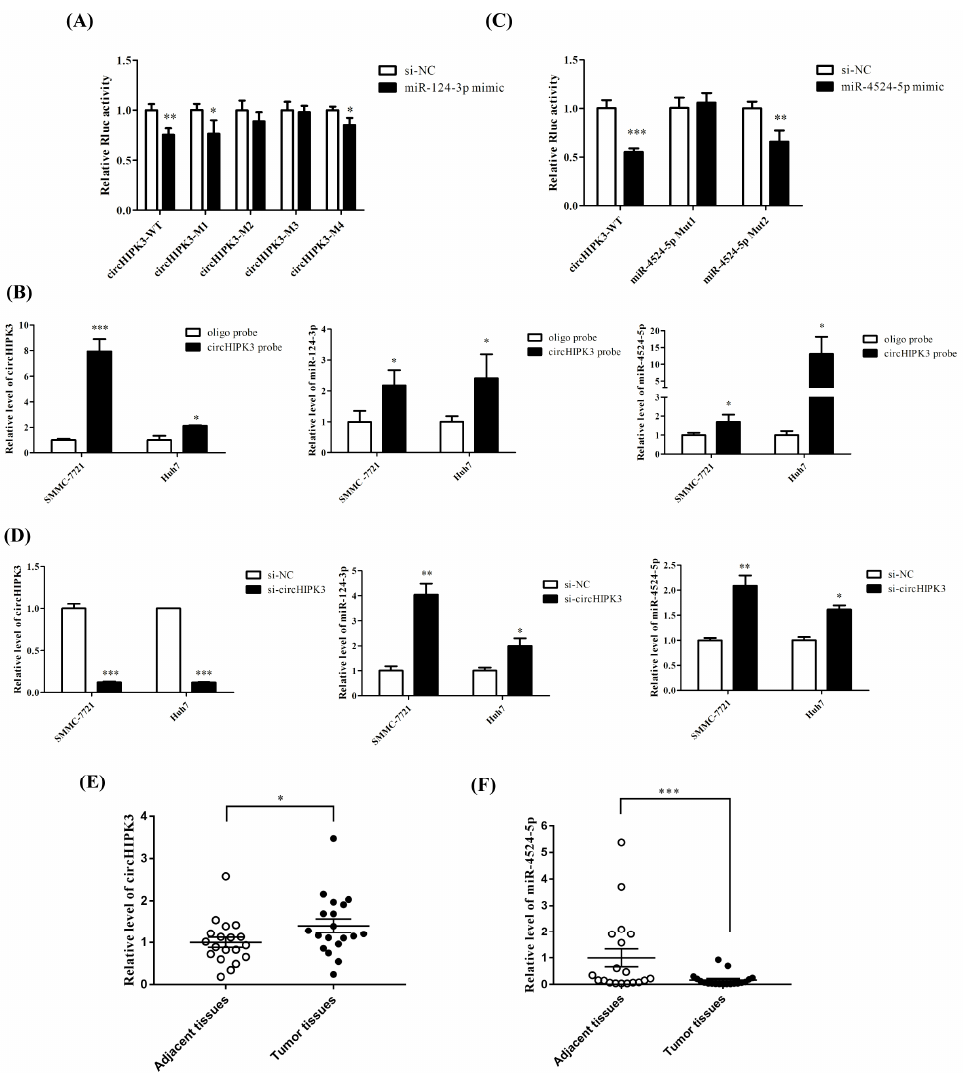
Figure 3. circHIPK3 interacted with miR-124-3p and miR-4524-5p. ( A ) Luciferase assay identified interaction between circHIPK3 and miR-124-3p. ( B ) circHIPK3 was highly enriched and both miR-124-3p and miR-4524-5p were detected in the precipitate in the probe group. Oligo probe was negtive control. ( C ) Luciferase assay identified interaction between circHIPK3 and miR-4524-3p. ( D ) Knockdown of circHIPK3 resulted in the corresponding increase in miR-124-3p and miR-4524-5p. ( E ) The expression of miR-4524-5p was found to be downregulated in HCC tissues than paired adjacent normal tissues. ( F ) The expression of circHIPK3 was found to be significantly higher in HCC tissues than paired adjacent normal tissues, n = 19. Differences between two experimental groups were analyzed by the Student’s t test. Wilcoxon test was applied to detect the differences between tumor tissues and paired adjacent tissues. * p < 0.05, ** p < 0.01, *** p < 0.001, compared with control group.